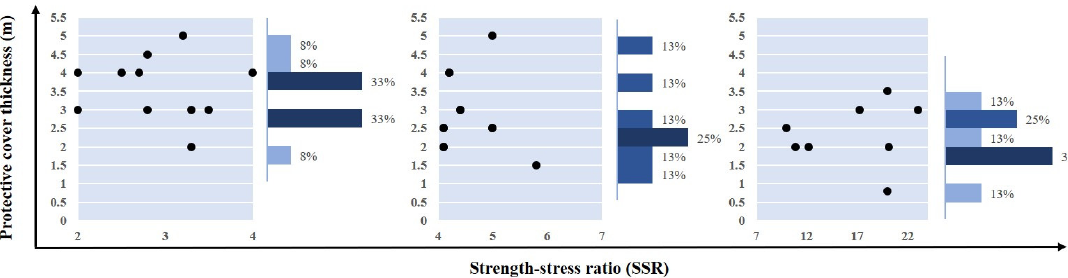
Figure 25. The dominant distribution of protective cover thickness under different SSR at the high side wall zone.